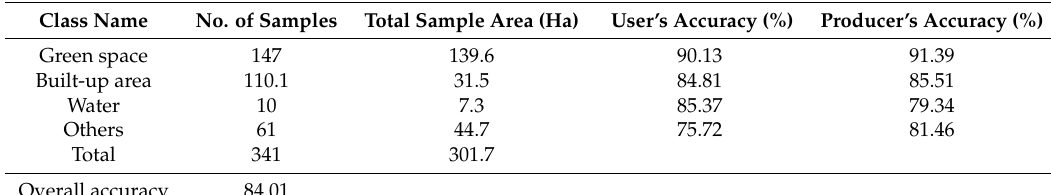
Table 6. Accuracy assessment of the classified map of Beijing.